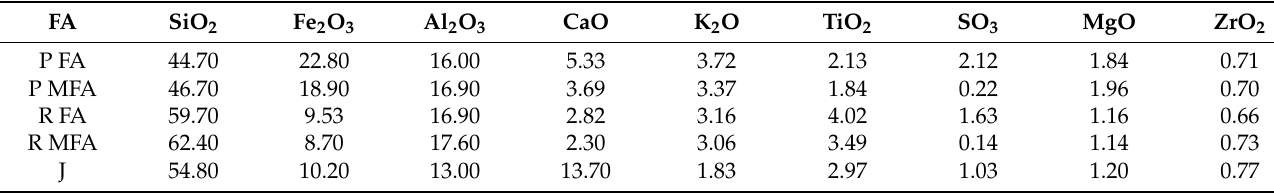
Table 3. Chemical composition of fly ash.